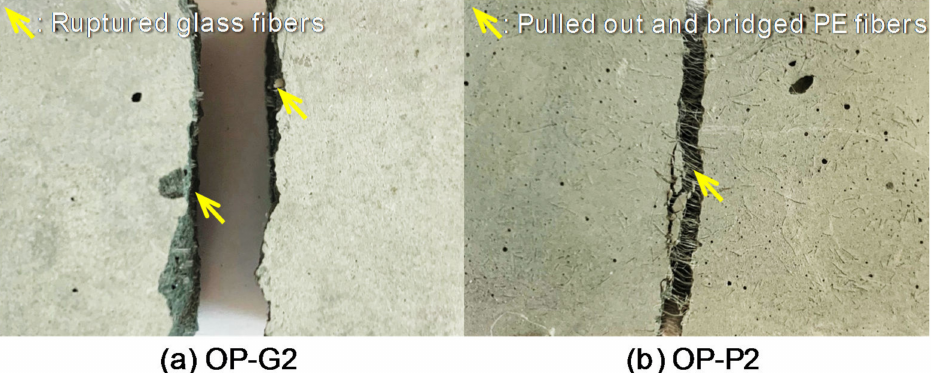
Figure 9. Pictures of the localized crack surface for the fiber failure mode: ( a ) OP-G2 and ( b )